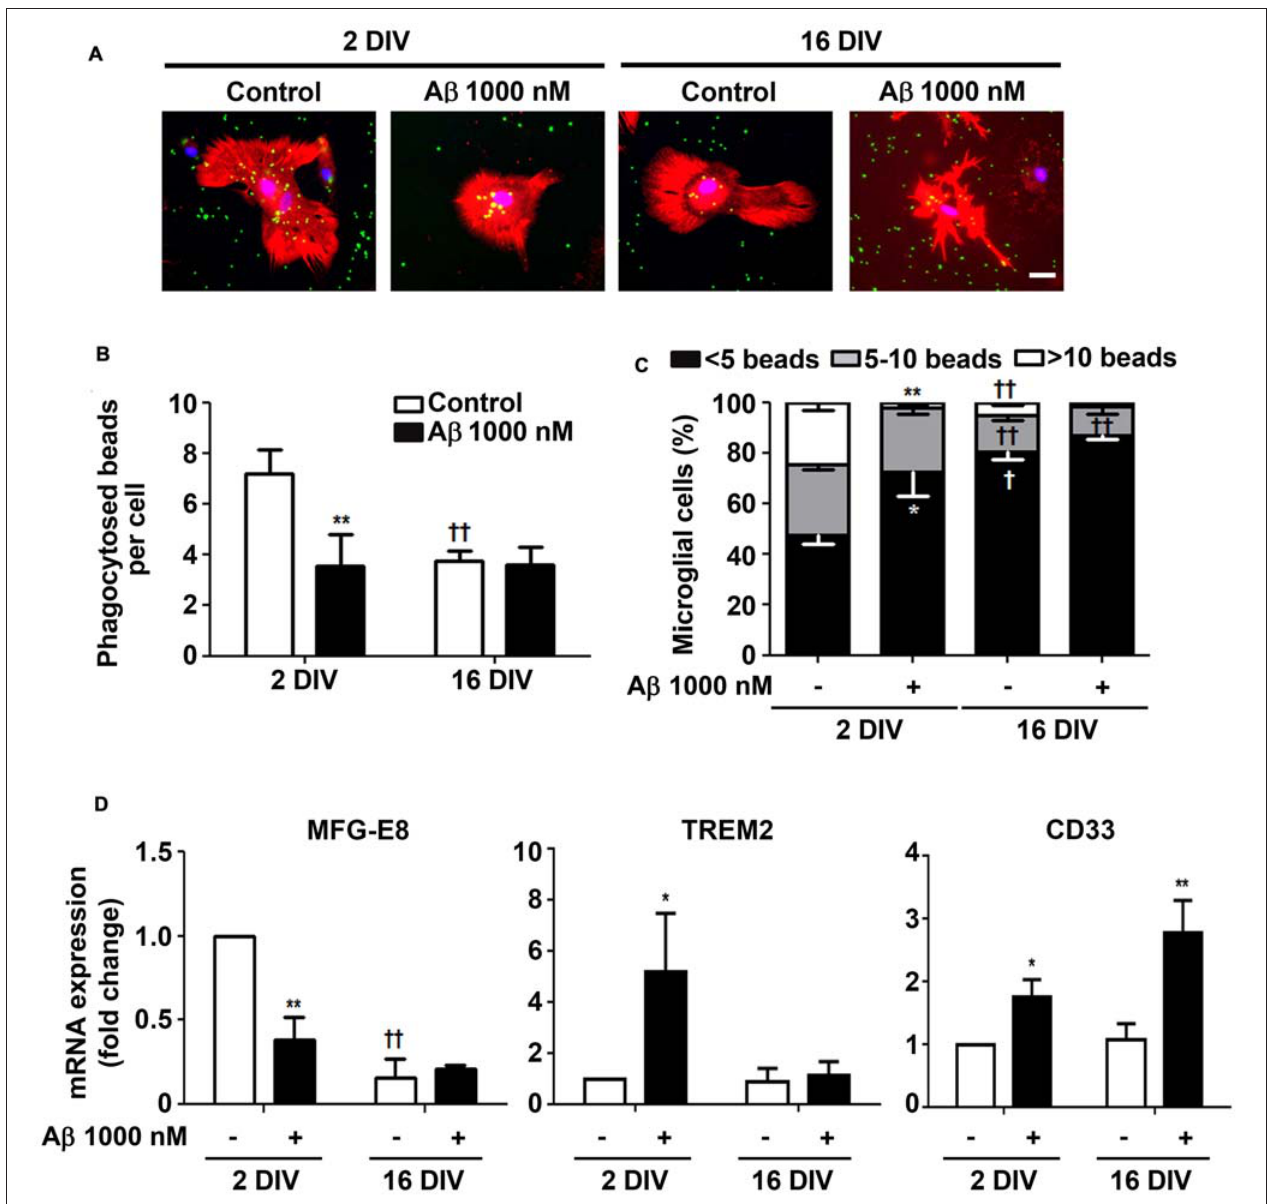
FIGURE 6 | Ability of microglia to phagocytose is reduced by amyloid- β (A β ) peptide mainly in the reactive cultured cells. Microglia that were kept in culture for 2 and 16 days in vitro (DIV) were treated with 1000 nM A β for 24 h. Phagocytic capacity was assessed after 75 min incubation with fluorescent latex beads. (A) Representative images of microglia immunostained for Iba1 (red) and stained with Hoechst for nuclei staining (blue) containing phagocytosed fluorescent latex beads (green). Scale bar equals 50 µ m. (B) Number of phagocytosed beads per cell and (C) number of microglial cells phagocytosing less than 5, 5–10 and more than 10 beads was counted. (D) Expression of milk fat globule-EGF factor 8 protein (MFG-E8), triggering receptor expressed on myeloid cells 2 (TREM2) and CD33, associated to microglial phagocytosis, was evaluated by Real-Time PCR. Results are expressed in graph bars as mean ± SEM. Cultures, n = 4 per group. Two-way ANOVA ( Post hoc Bonferroni test): ∗ p < 0.05 and ∗∗ p < 0.01 vs. respective non-treated Control; † p < 0.05 and †† p < 0.01 vs. 2 DIV; (D) MFG-E8: DIV × A β interaction F ( 13.9 ) , p <